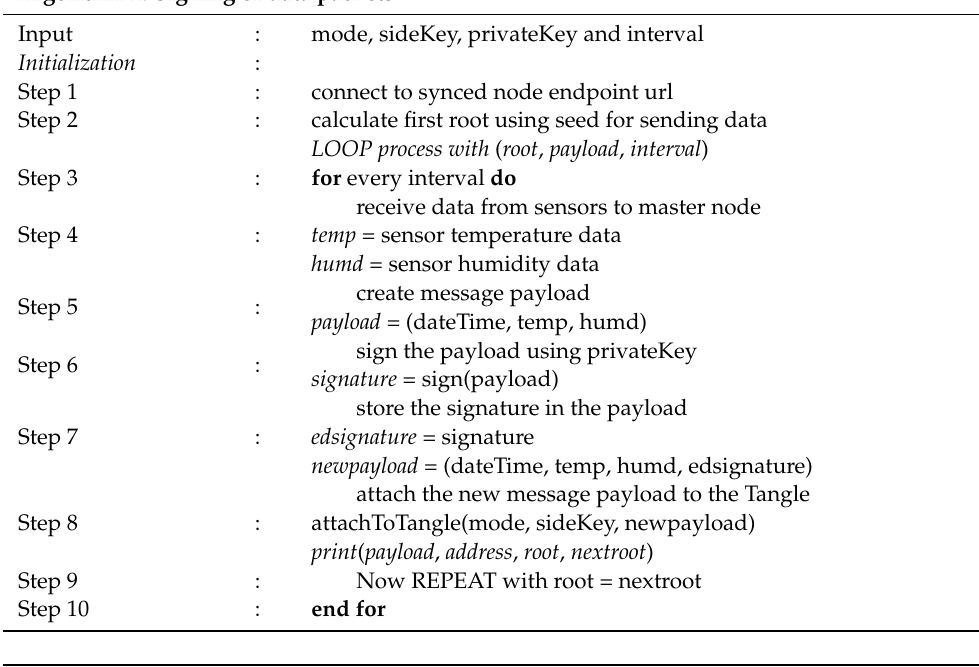
Algorithm 2. Signing of data packets